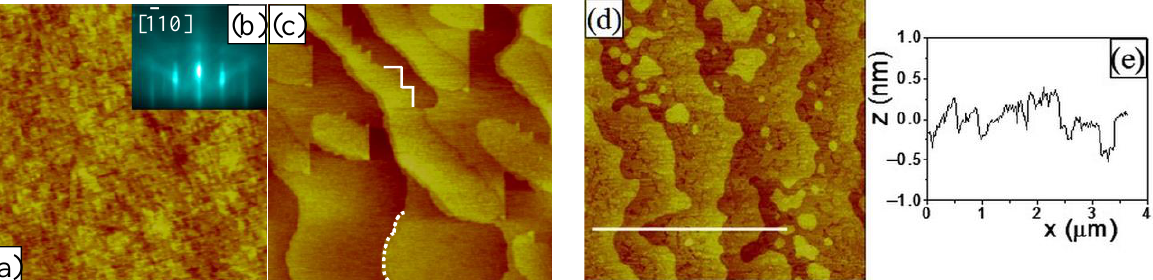
Figure 1. AFM topographic images: ( a ) as-received (110) NdGaO 3 substrate, annealed for 0.5 h at 550 °C under O 2 flow (100 L/h), showing a non-terraced structure; ( b ) the RHEED pattern corre- sponding to the substrate from ( a ); ( c ) (110) NdGaO 3 substrate annealed in air for 1 h at 1000 °C; ( d ) (001) NdGaO 3 substrate after 0.5 min of chemical etching in commercial BHF solution, followed by